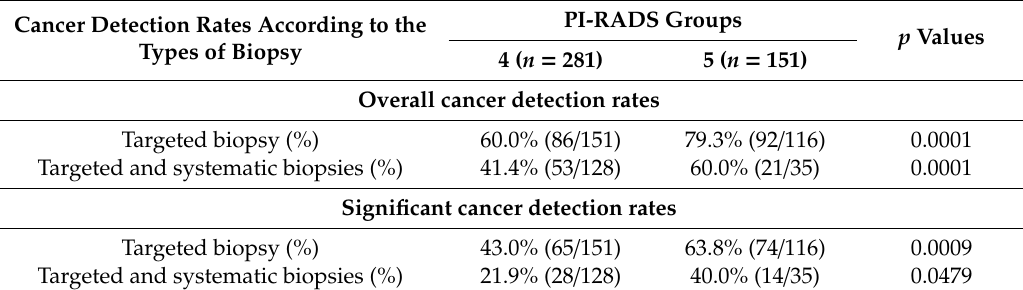
Table 3. Cancer detection rates of the PI-RADS 4 and 5 lesion groups according to the type of biopsy. Cancer Detection Rates According to the Types of